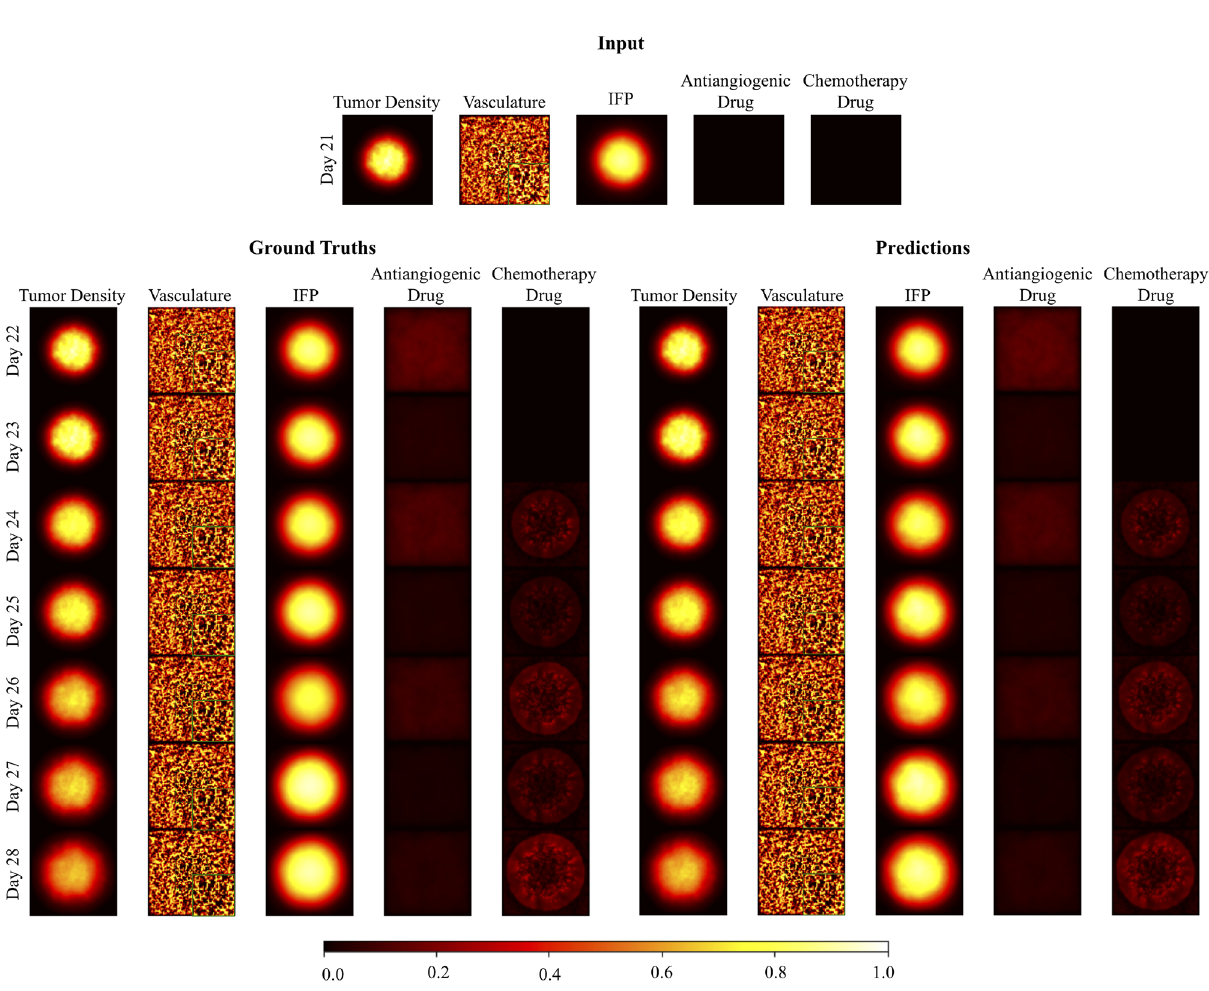
Figure 1. The synthetically generated tumor microenvironment maps of the example patient. The patient receives treatment between days 21 and 28. The application of the antiangiogenic drug is at the end of days 21, 23, 25, and 27 while the chemotherapy drug is applied at the end of days 23, 25, and 27. Drug scalars A and d have the values of 0.6 and 0.8 respectively. The model takes initial tumor density, vasculature, IFP, antiangiogenic drug, and chemotherapy drug maps as an input (on the top). Ground truth maps that show the ongoing treatment from day 22 to day 28 (on the left). Predicted maps that are iteratively generated from day 22 to day 28 (on the right). (In the figure, we present zoomed version of the center of the vasculature maps on the bottom right corner and the scalebar represents the scale of the pixel values of the tumor microenvironment maps.)